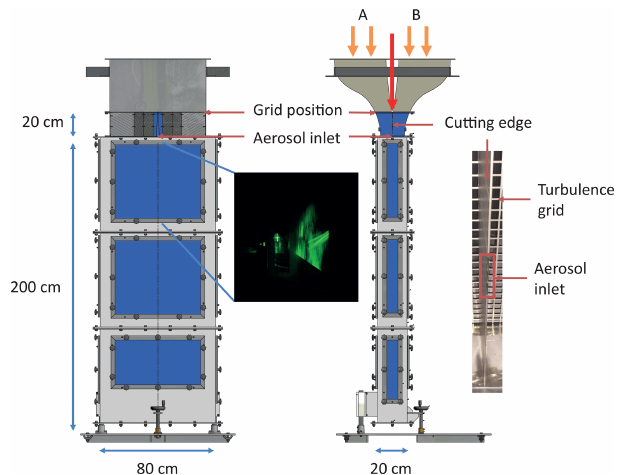
Figure 2. A sketch of the measurement section is shown includ- ing its dimensions as well as the position of the turbulence grids, the cutting edge and the aerosol inlet (© by Ingenieurbüro Mathias Lippold, VDI; TROPOS). The red arrow marks the location where the particles are injected. The picture in between the sketches of the measurement section shows a formed cloud which is illuminated by a green laser light